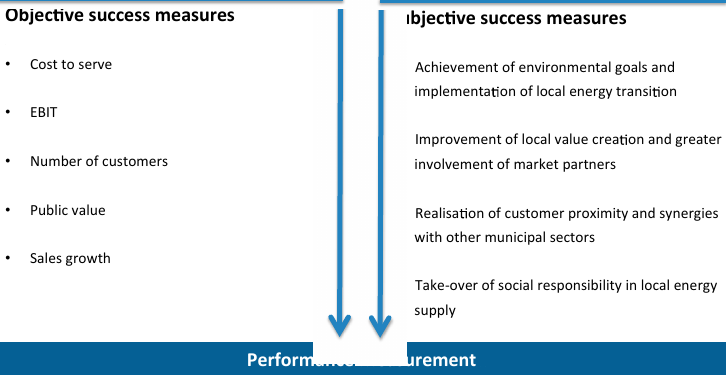
Figure 3. Objective and subjective success measures.